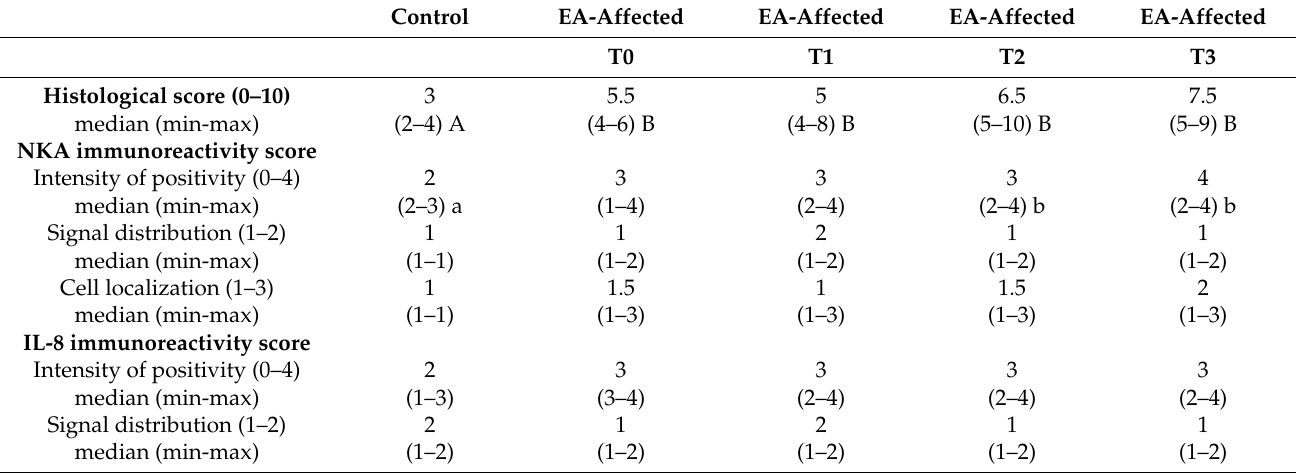
Table 2. Comparison of median value (min-max) of histological, NKA and IL-8 immunoreactivity scores acquired from bronchial biopsies, between control horses and EA-affected horses at T0, T1, T2, T3. Mann–Whitney test. a,b: different letters indicate significant differences ( p < 0.05); A, B: different letters indicate significant differences ( p < 0.01).